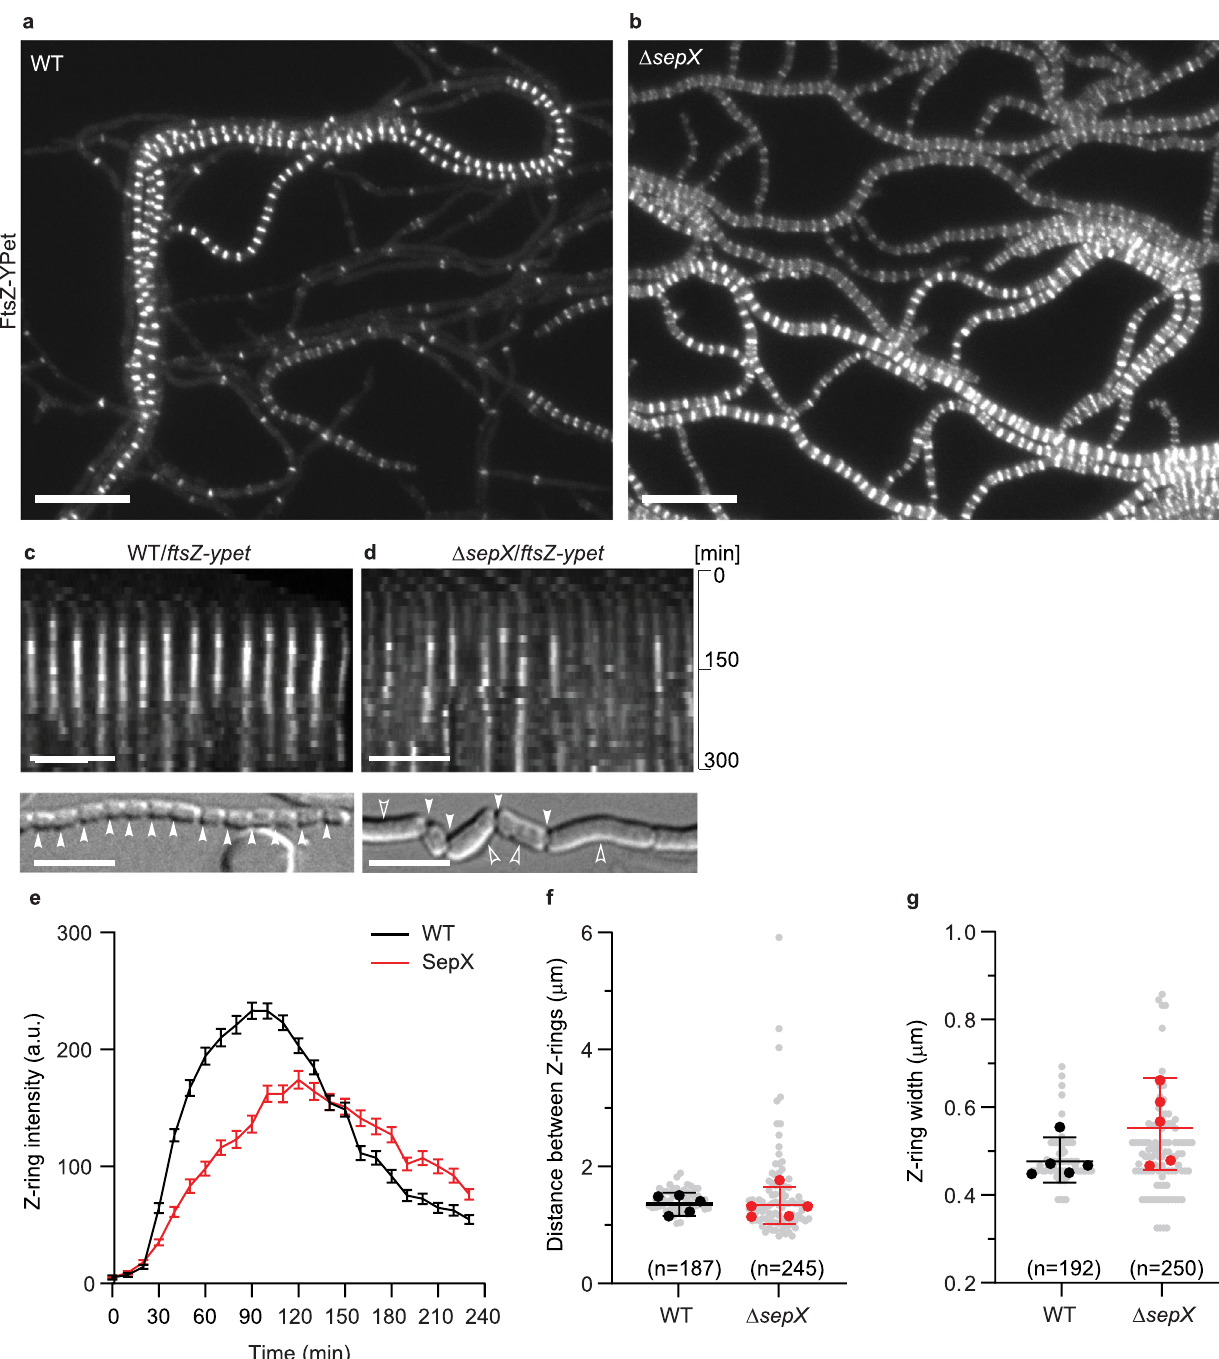
Fig. 4 SepX is important for Z-ring stability and architecture during sporulation-speci fi c cell division. Still images from Supplementary Movie 2 and 3 showing YPet-labelled Z-ring formation in sporulating hyphae of a the wild type (SS12) or b the Δ sepX mutant (MB180). Scale bar: 10 μ m. c and d Subsection of representative kymographs (top panel) showing the spatiotemporal localization of FtsZ-YPet in c the wild type (WT, SS12) and d the Δ sepX mutant (MB180). Y -axis shows imaging duration. The bottom panel depicts terminal sporulation phenotype with fi lled arrowheads pointing at completed sporulation septa, open arrowheads at failed septation. Scale bars: 5 μ m. Complete kymographs are shown in Supplementary Fig. 4d, e. e Fluorescence intensity traces of FtsZ-YPet (Z-rings) over time derived from sporulating WT (SS12) and Δ sepX mutant hyphae (MB180). Shown are the mean fl uorescence intensity traces (mean± s.e.m.) collected from Z-rings of fi ve sporulating hyphae for each strain ( n = 5 independent hyphae per strain). f Distance and g width of Z-rings in sporulating hyphae of WT (SS12) and sepX -de fi cient hyphae (MB180). The analysis is based on the same data time- lapse data that was used to generate panel ( e ). Shown are the mean values for Z-ring distance and width for reach replicate (black and red dots) ± 95% CI. n -number of Z-rings from fi ve representative hyphae per strain were analyzed. The data shown here are representative of experiments performed in duplicate. Source data are provided as a Source Data fi le for ( e – g